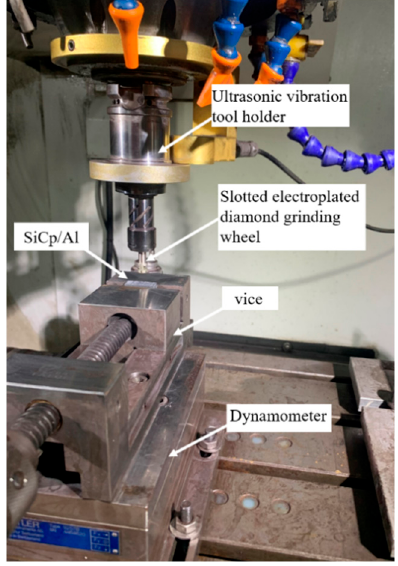
Figure 1. Ultrasonic vibration-assisted grinding test platform.